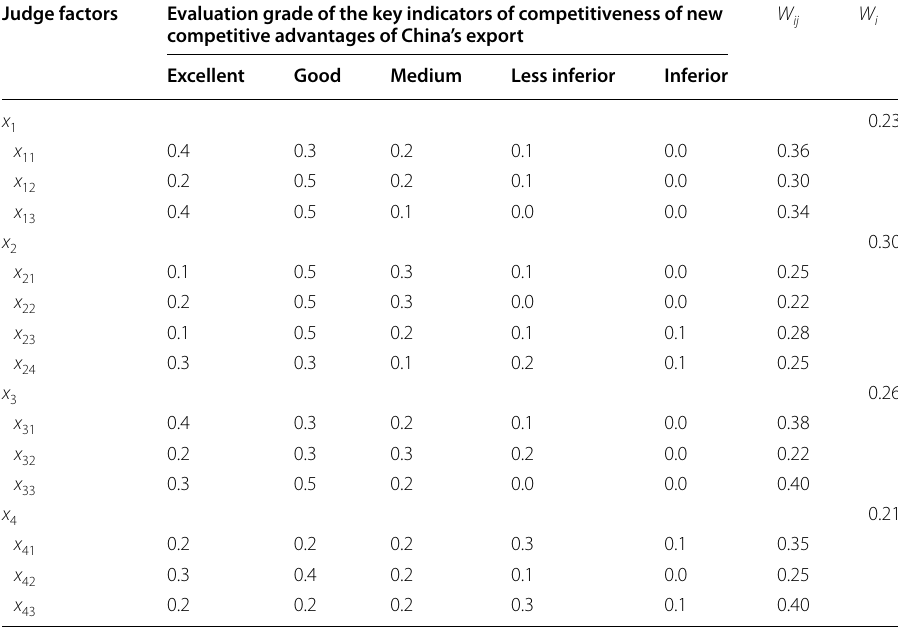
The smaller C is, the better the prediction effect is; the higher P is, the better the prediction effect is